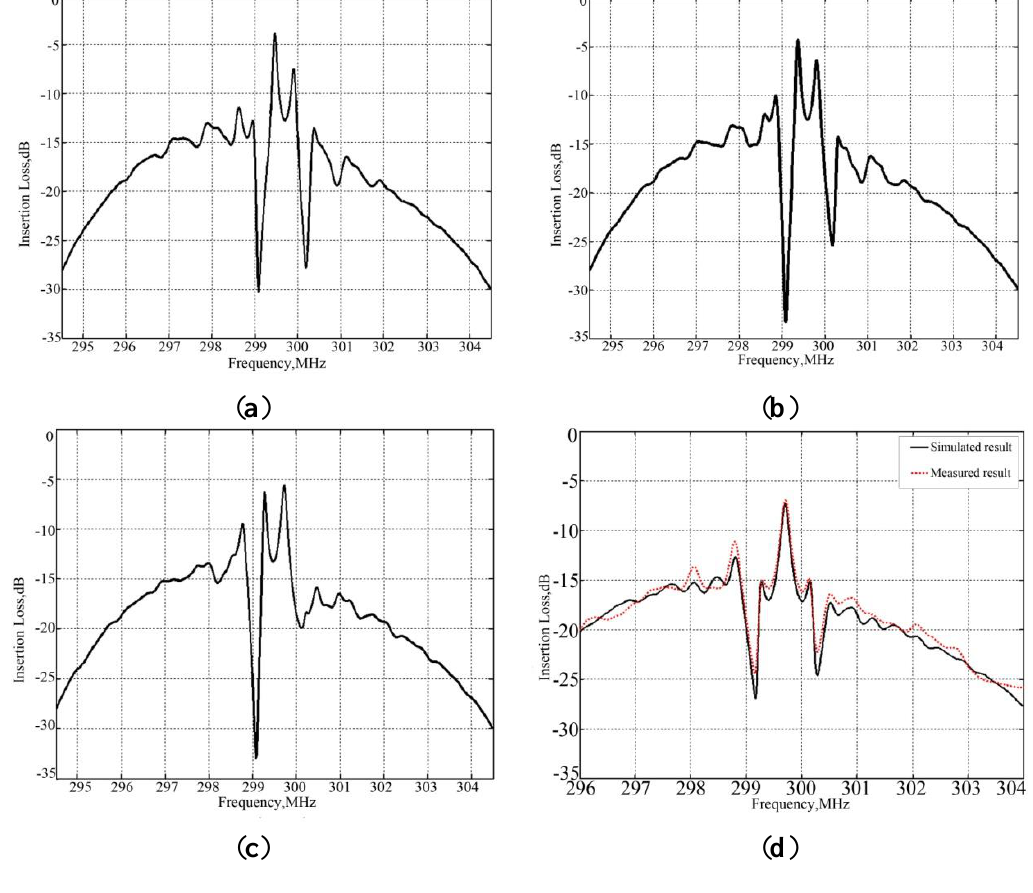
Figure 3. Simulated frequency response of SAW resonator with different coating